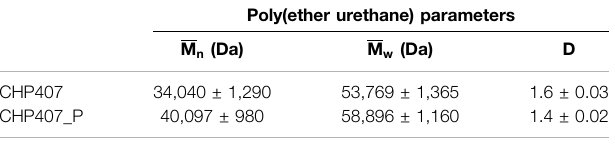
TABLE 1 | Number Average Molecular Weight ( M n ), Weight Average Molecular Weight ( M w ) and polydispersity index (D) estimated for CHP407 and CHP407_P polymers.